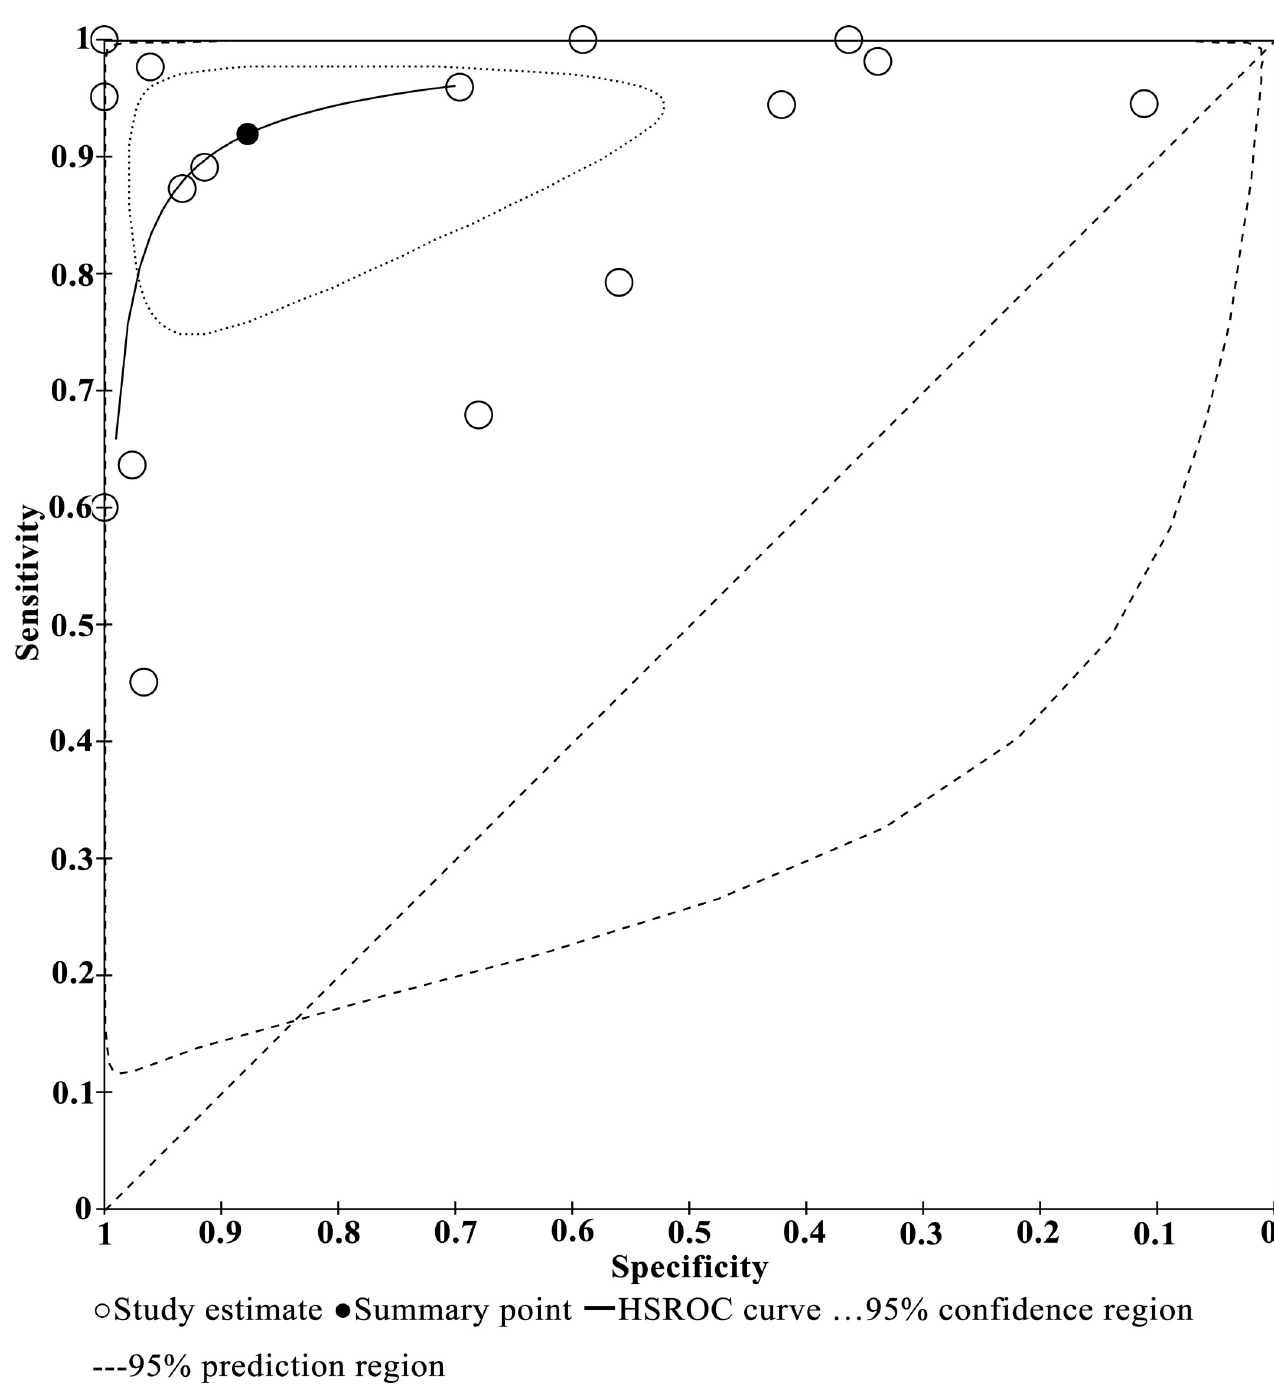
Fig 5. HSROC curve of PCR tests used to diagnose S . japonicum infections.